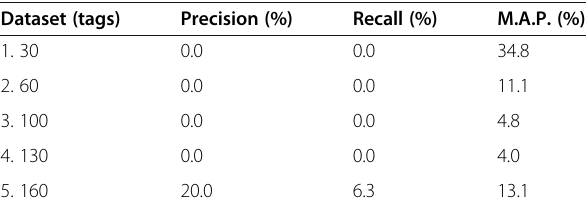
Table 1 The “ Performance Per Tag ” of 5 iterations with a 1-h training Dataset (tags)